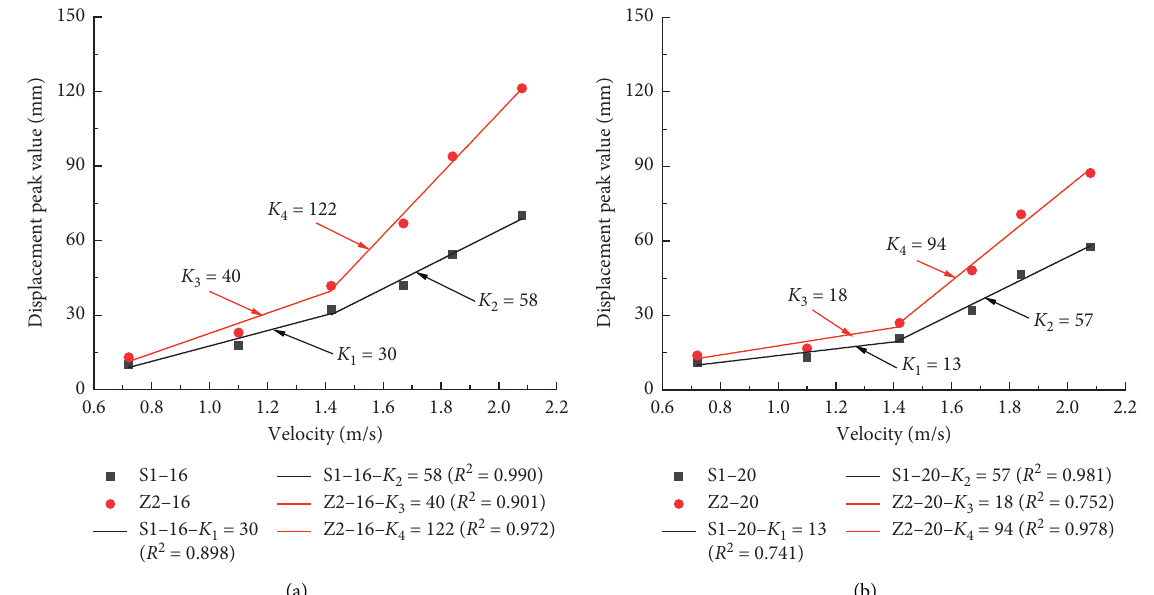
Figure 14: Fitting curve of the top displacements and impact velocities of the first and second groups.